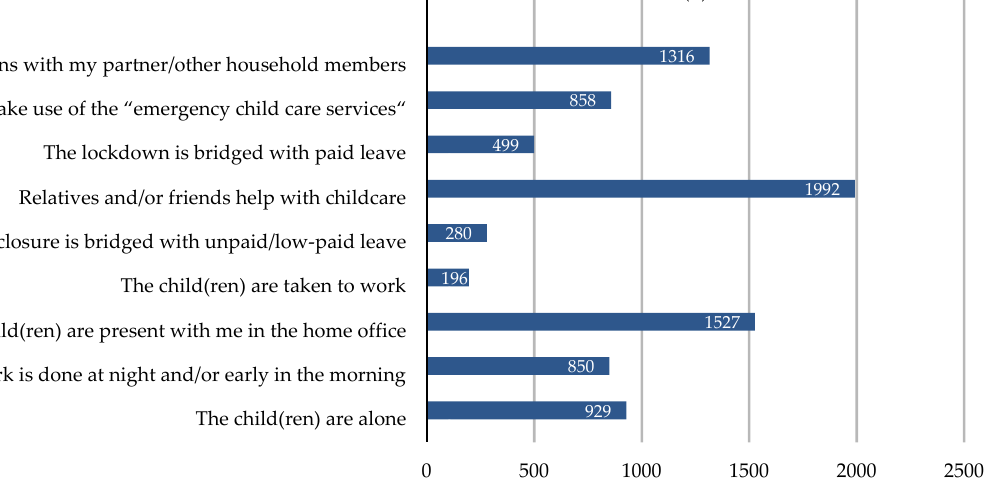
Figure 1. Who is watching the children? Working parents‘ most popular strategies for dealing with the closure of schools, kindergartens, and nurseries.